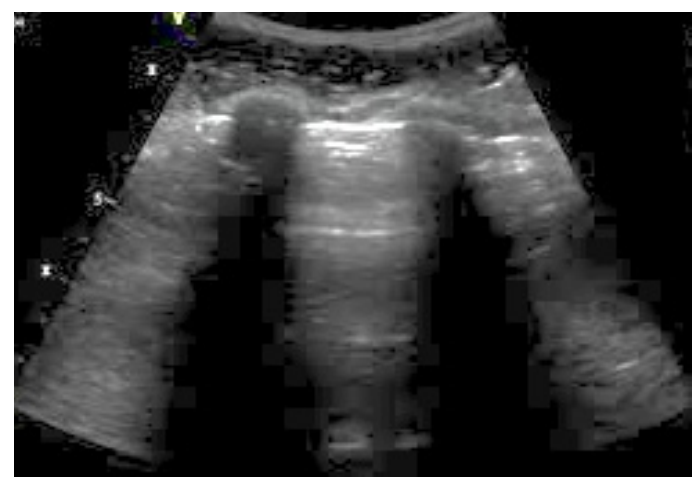
Figure 1. A-lines (arrow).